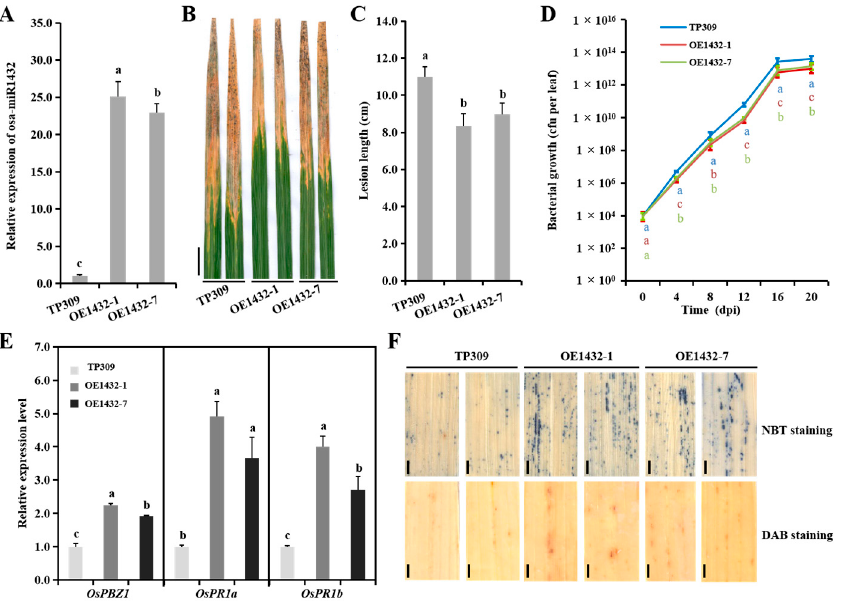
Figure 2. Osa-miR1432 modulates Xoo resistance in rice. ( A ) The expression detection of osa-miR1432 in representative overexpressing transgenic lines. SnRNA U6 served as the internal reference. ( B ) Lesions on OE1432 lines (OE1432-1 and OE1432-7) and the TP309 at 20 dpi. Scale bar, 2 cm. ( C ) Lesion lengths on OE1432 plants (n = 20) at 20 dpi. ( D ) Bacterial growth indicated by the numbers of colony-forming units (cfu) per leaf in OE1432 lines and TP309. ( E ) The basic expression of OsPBZ1 , OsPR1a and OsPR1b in OE1432 lines and TP309. ( F ) The histochemical detection of ROS levels using NBT and DAB staining in OE1432 lines and TP309 at 4 dpi. Error bars indicate standard deviation ( n = 3). Scale bar, 2 mm. Different letters above the bars indicate significant differences ( p < 0.01) determined by one-way analysis of variance (ANOVA) followed by post hoc Tukey HSD analysis.